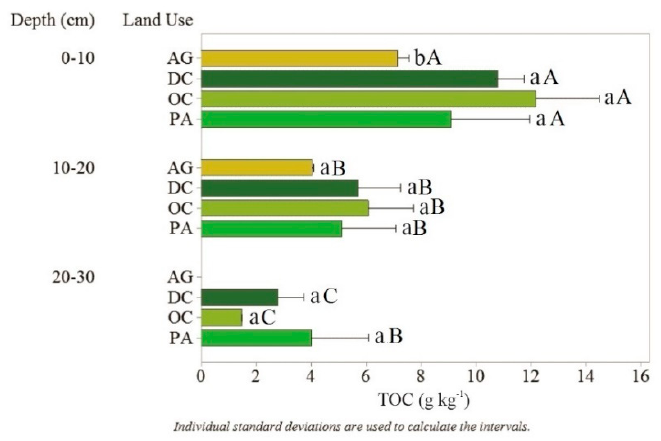
Figure 3. Total organic carbon (TOC) content by layer under di ff erent types of land use in the semi-arid region of Brazil. Note: equal lowercase letters represent no statistical di ff erence between land uses in the same layer according to the Kruskal–Wallis test ( p < 0.05). Di ff erent uppercase letters represent a statistical di ff erence between layers for the same land use according to the Kruskal–Wallis test ( p <